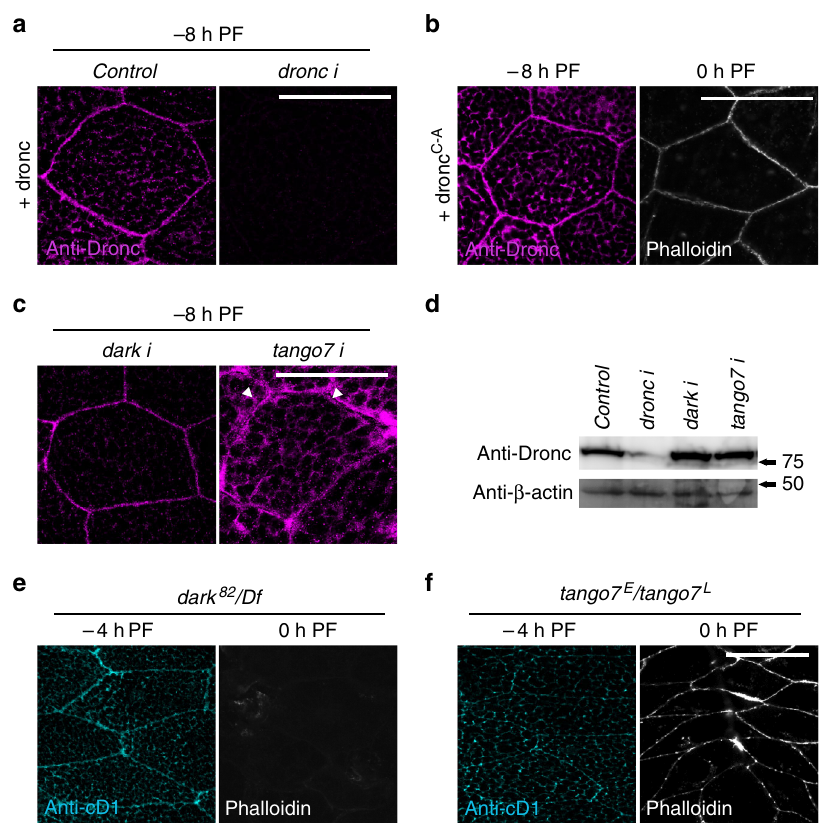
Fig. 3 Tango7 is required for cortical localization and activity of Dronc in living salivary glands. a Dronc localizes to the cortex of salivary glands at the end of larval development. Immuno fl uorescent staining using an antibody to detect Dronc protein (anti-Dronc, in magenta ) in salivary glands overexpressing dronc under control of Sgs3-GAL4 ( + dronc ) shows that Dronc localizes to the cortex of salivary gland cells at − 8 h PF. Co-expression of dronc-RNAi abolishes anti-Dronc staining. b F-actin dismantling requires Dronc catalytic activity. Anti-Dronc staining in salivary glands overexpressing a catalytically inactive Dronc ( + dronc C-A , in magenta ) under control of Sgs3-GAL4 reveals that Dronc C-A still localizes to the cortex at − 8 h PF. However, phalloidin staining, in white , shows that F-actin does not break down in these glands at 0 h PF. c tango7 , not dark , regulates cortical localization of Dronc. Anti-Dronc staining, in magenta , in salivary glands overexpressing dronc under control of Sgs3-GAL4 shows that Dronc still localizes to the cortex upon co-expression of RNAi against dark . In contrast, tango7 RNAi knockdown causes Dronc to diffuse away from the cortex toward the cytoplasm, with clear gaps lacking anti-Dronc staining visible at the cortex ( white arrowheads ). The cytoplasm at this stage is fi lled with secretory granules ( black “ spots ” ). d Dronc levels are not reduced in tango7 -RNAi salivary glands. Western blot analysis of Dronc protein expression levels in dronc-RNAi , dark-RNAi , and tango7-RNAi salivary glands (under control of Sgs3-GAL4 ) shows that Dronc levels are dramatically reduced upon overexpression of dronc-RNAi , but are not decreased upon expression of dark-RNAi or tango7-RNAi . Salivary glands were dissected at − 8 h PF; β -actin used as loading control. e , f tango7 , not dark , is required for cortical caspase activation and dismantling of F-actin. e Cortical anti-cD1 staining, in cyan , is not disrupted in dark mutant salivary glands at − 4 h PF. Phalloidin staining, in white , shows that F-actin breaks down normally in dark mutant salivary glands. f In contrast, cortical anti-cD1 staining is abolished at − 4 h PF and F-actin fails to break down at 0 h PF in tango7 mutant salivary glands. Scale bars represent 100 µ m. Df, de fi ciency, PF, puparium